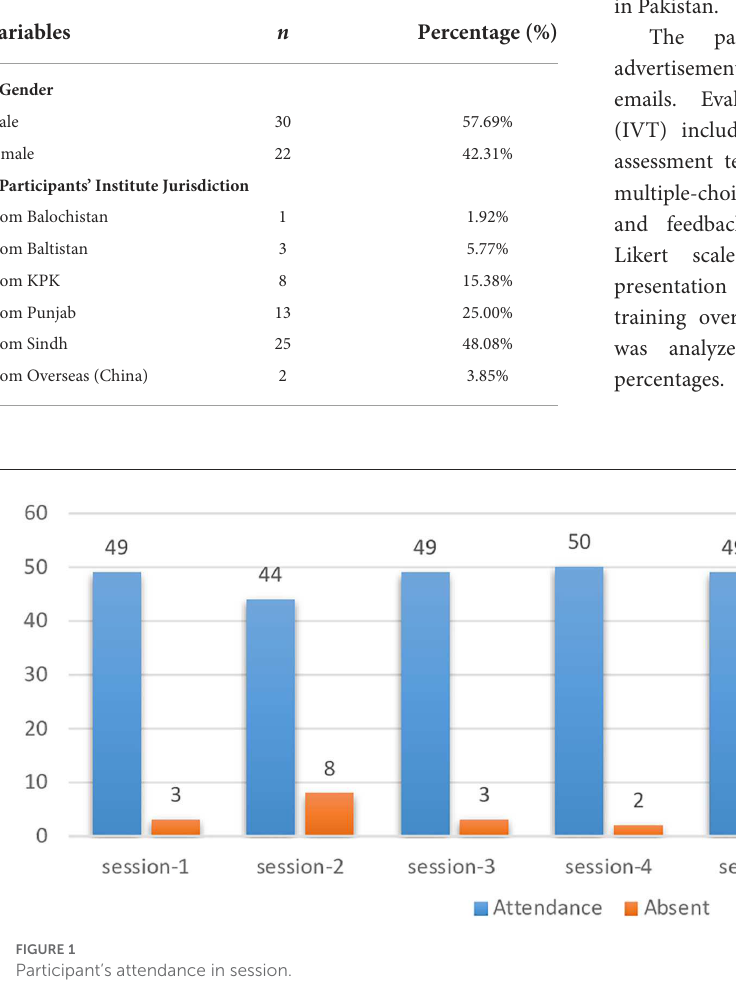
TABLE 1 Participants’ sociodemographic information.